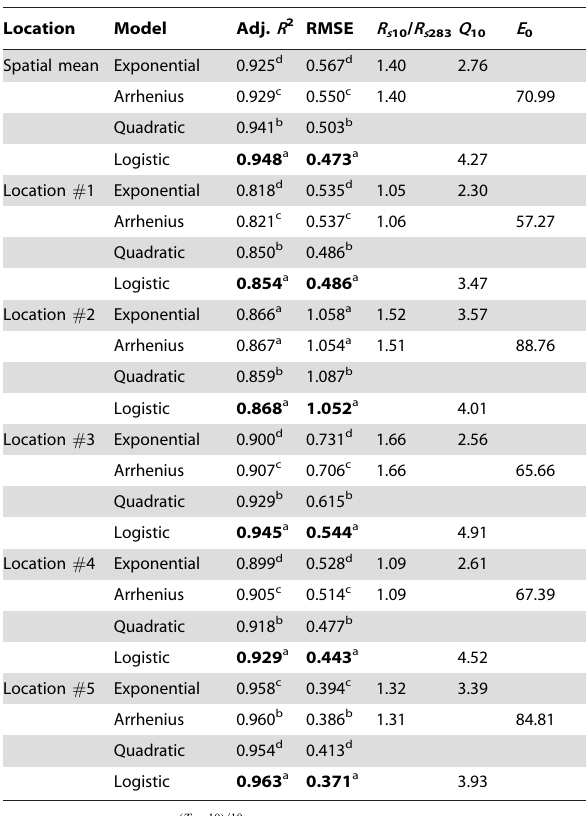
Table 1. Parameters and statistics for the analysis of the dependence of daily mean soil respiration ( R s ) on soil temperature ( T s